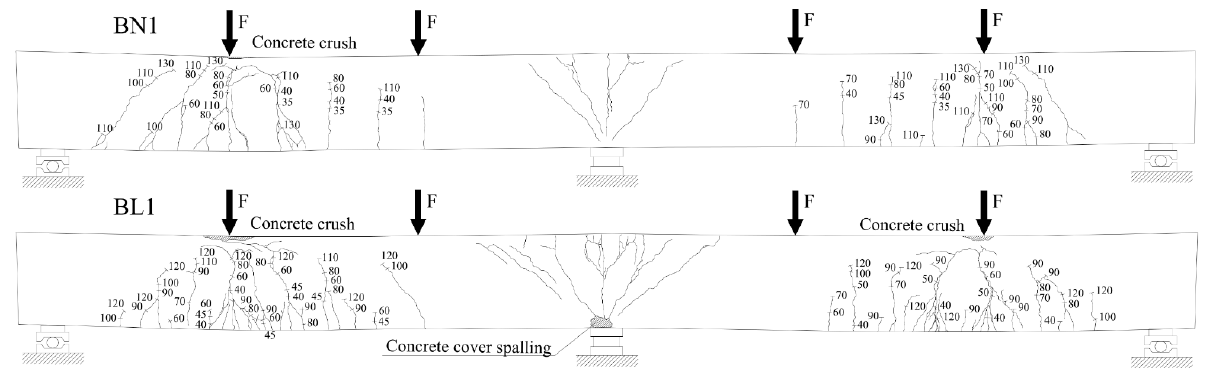
Figure 6. Crack propagation in BN1 and BL1 beams. Note: numerals given in figures indicate the applied load F (in kN). The drawings present the deformed beams after the removal of the load.